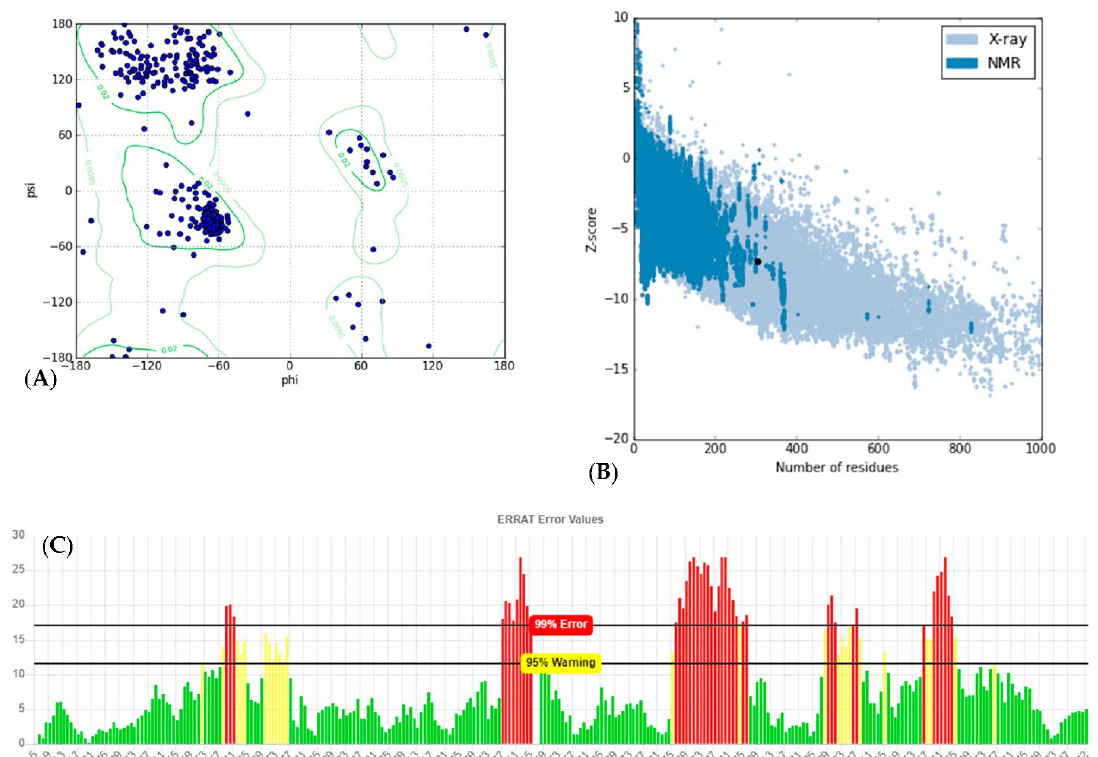
Figure 3. Structural validations of predicted CHT model: ( A ) Ramachandran plot: as shown in plot, 98.9% of residues are in the most favored and allowed regions, while 1.1% are within the disallowed region (3 residues). ( B ) Z-plot: Z-score of the model is shown as a black dot within the plot region, which is in the range of the native model with the same size. ( C ) ERRAT evaluation plot showing the quality of model based on non-bond interactions. ERRAT quality score was calculated to be